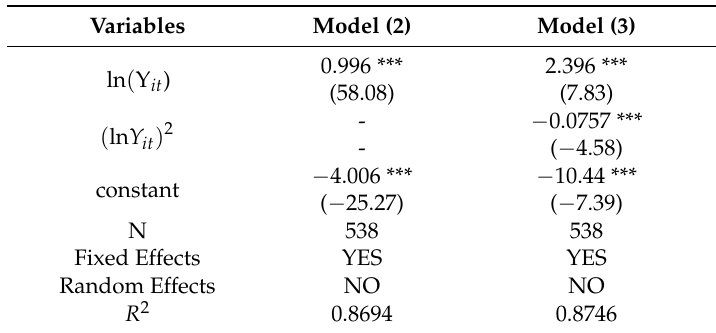
Table 5. Estimate results of Models (2) and (3).